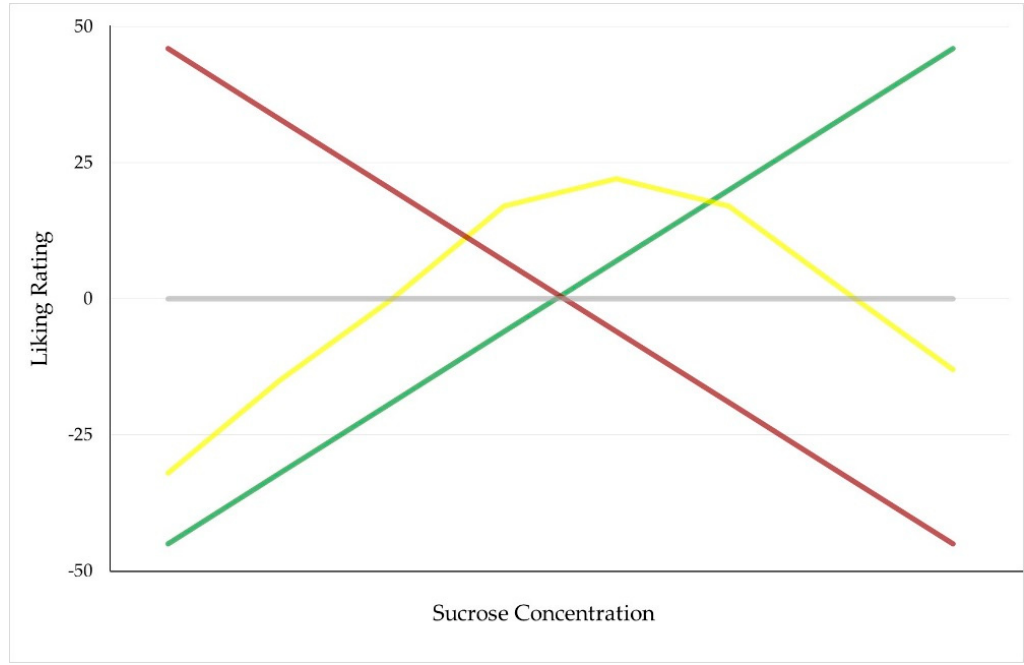
Figure 1. Graphical representation of the most commonly reported sweet taste liker phenotypes. The green line corresponds to a phenotype characterized by a rise in liking with increasing sucrose concentration (e.g., sweet liker phenotype), yellow line illustrates an inverted U-shaped hedonic response as a function of sucrose concentration (e.g., inverted-U phenotype), grey line represents an insensitive response to changes in sucrose concentration, and red line corresponds to a phenotype characterized by a decline in liking as sucrose concentration increases (e.g., sweet disliker phenotype). Adapted with permission from Reference [11] .